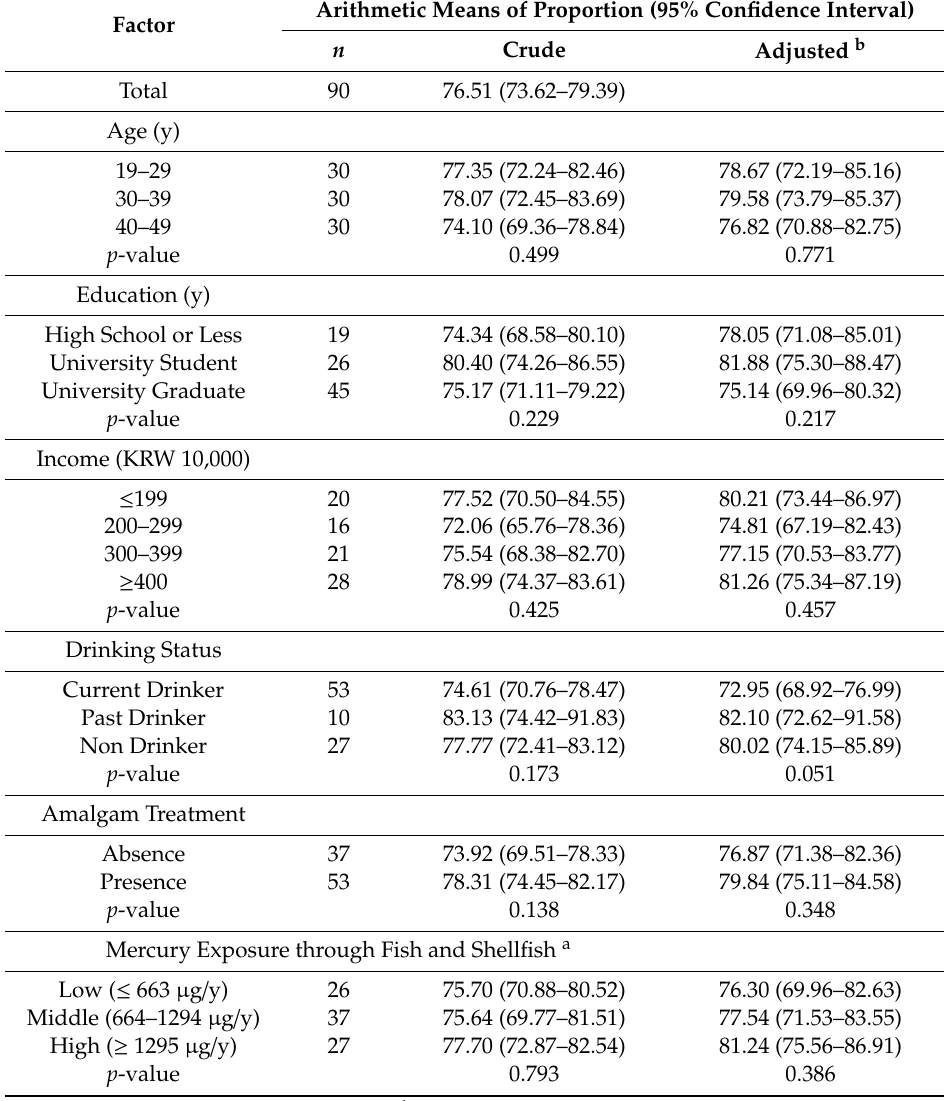
a : Simple 22-item Food Frequency Questionnaire b : Adjusted for all demographic and lifestyle variables in the